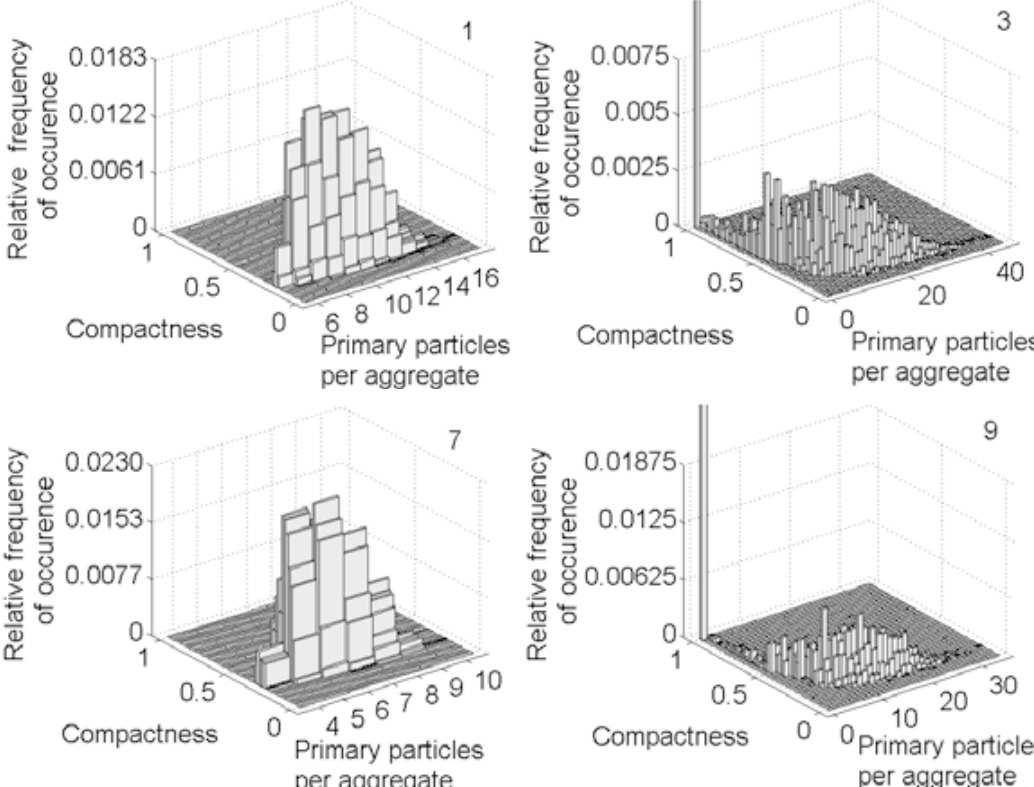
Fig. 5 Two-dimensional histogram representation of the final particle ensemble. Each bar shows the frequency of occurrence of aggre- gates in a certain interval of compactness and primary particles per